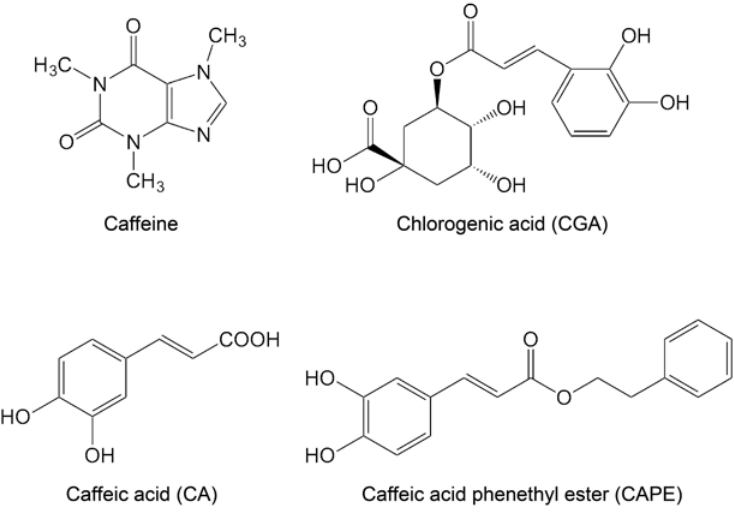
Figure 1. Structures of coffee components.